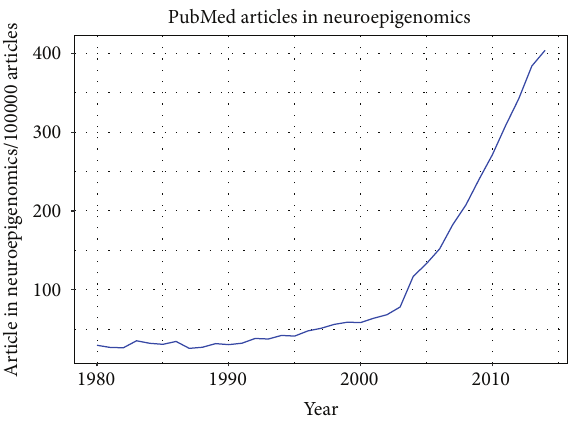
Figure 1: Trends in publications in the field of neuroepigenetics. The plot shows the number of publications on PubMed by year, nor- malized by the total of number of articles. The 𝑥 -axis represents the years,andthe 𝑦 -axisplotsthenumberofarticlesinneuroepigenetics per 100.000